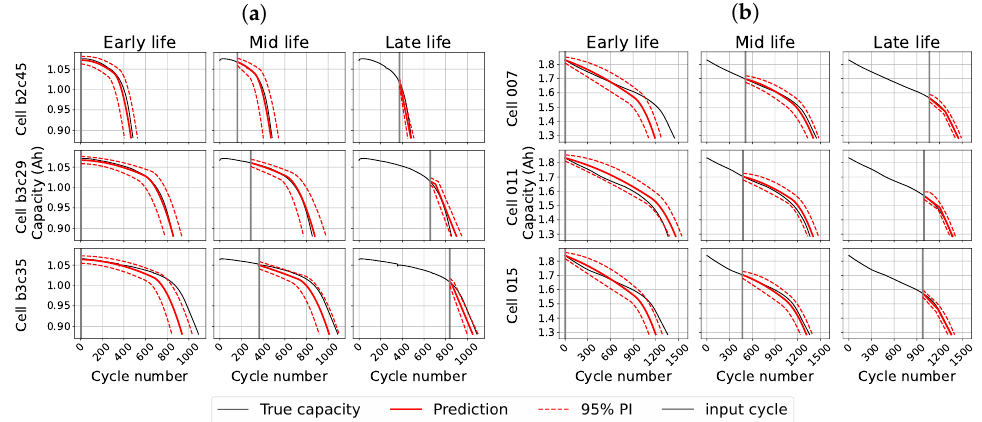
Figure 1. e -forgetting one-cycle model online prediction for three (randomly selected) test cells from each dataset. ‘Early life’ denotes prediction from cycle 3, ‘Mid life’ ∼ 40% of life and ‘Late life’ ∼ 80% of life. ( a ) Severson–Attia dataset; ( b ) Baumhöfer dataset.